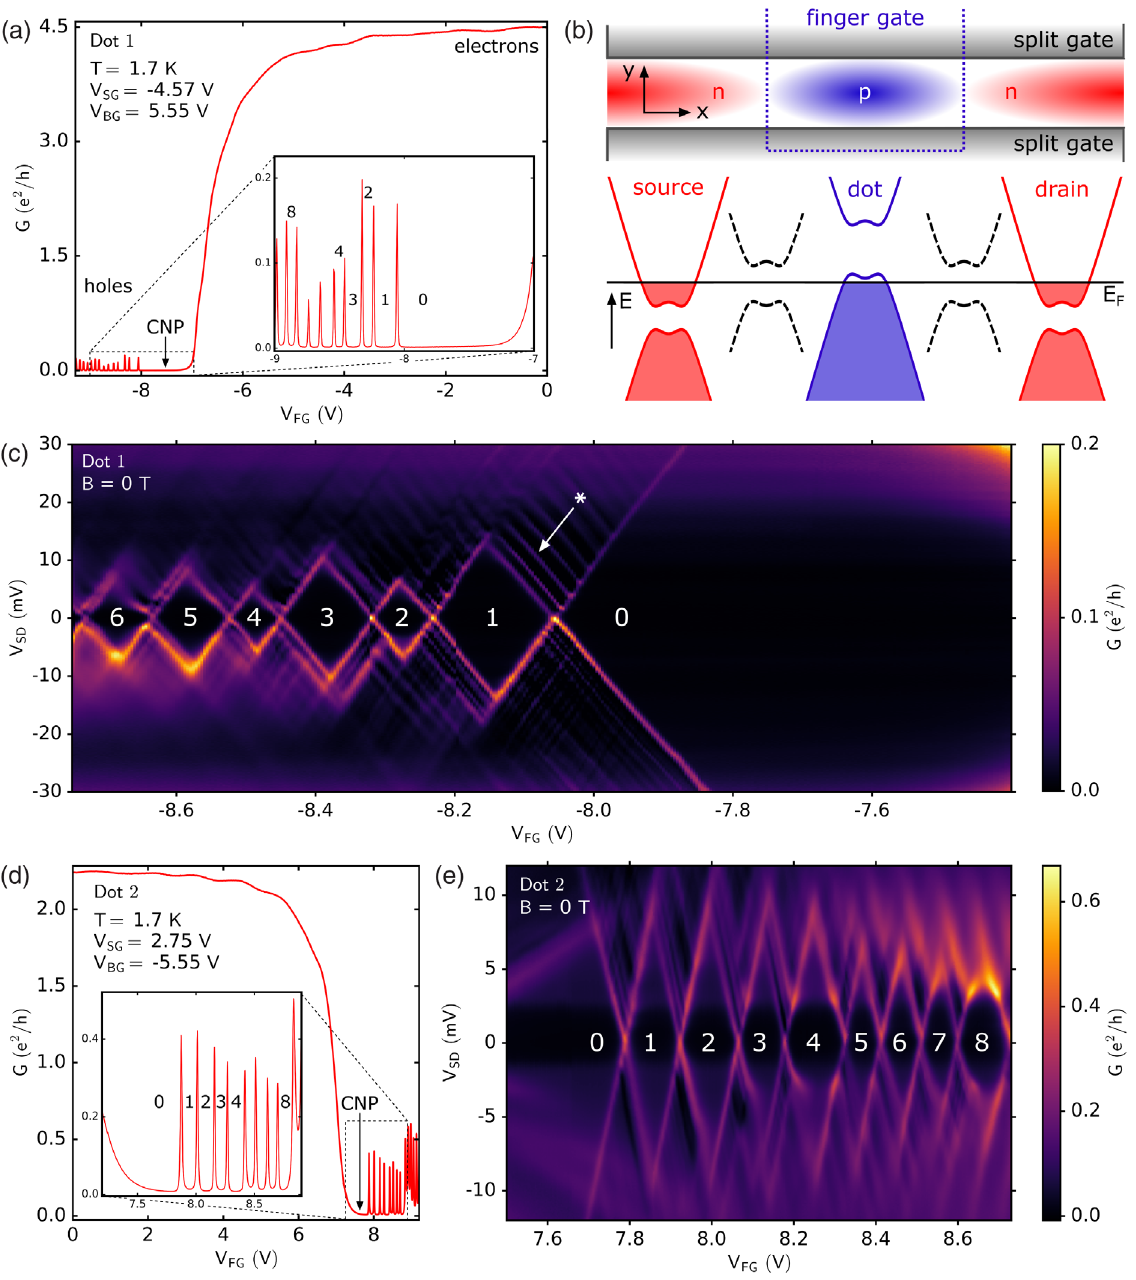
FIG. 2. (a) Conductance trace for p -type QD 1. (b) Schematic of the band structure at different positions along the current direction in the channel. Black dashed lines schematically show the band alignment between the dot region and the leads. (c) Coulomb diamonds in the hole regime for QD 1, with an asterisk indicating regularly spaced resonances parallel to the diamond boundaries. (d) Conductance trace and (e) Coulomb diamonds for the n -type QD 2. Numbers in (a) and (c), as well as (d) and (e) indicate the occupation of the QDs with holes or electrons, locally reduced until complete pinch-off is reached at the charge neutrality point (CNP) at about − 7 . 5 V.